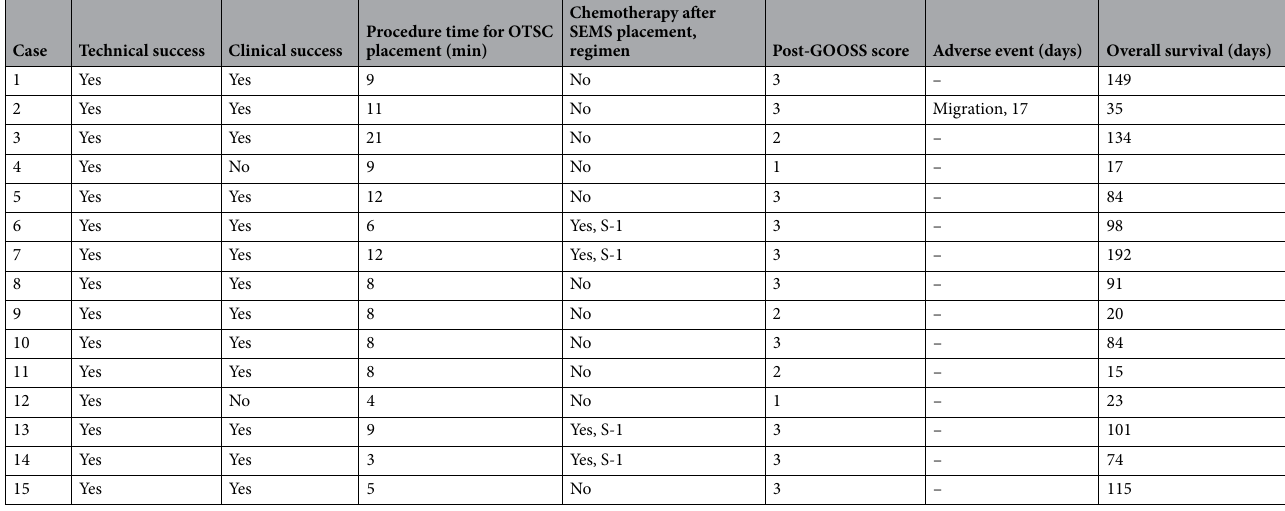
Table 2. Treatment outcomes and adverse events. GOOSS gastric outlet obstruction scoring system, OTSC over-the-scope-clip, SEMS self-expandable metal